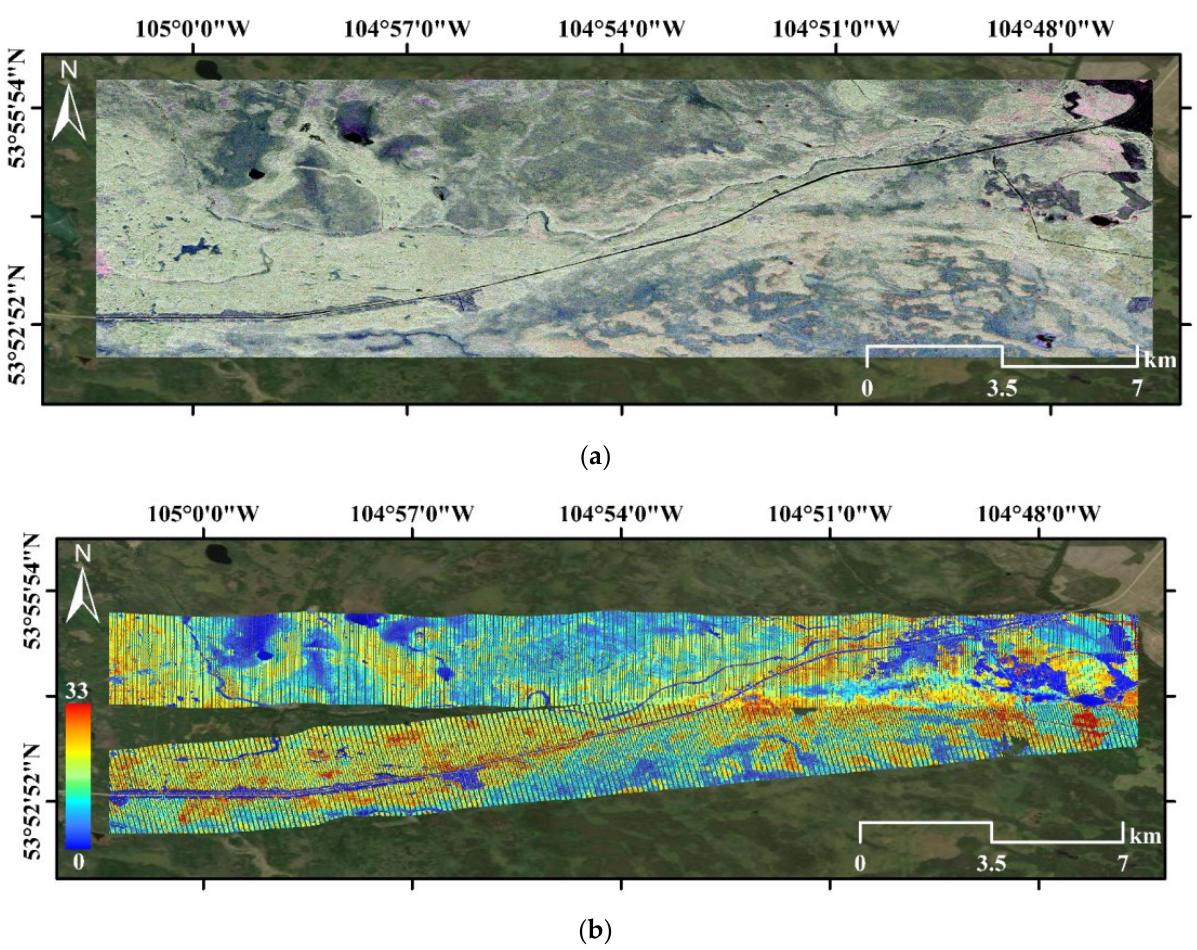
Figure 1. Study area in the Boreal Ecosystem Research and Monitoring Sites (BERMS): ( a ) UAVSAR Pauli color composite image. Red: | S HH − S VV | 2 , Green: 2 | S HV | 2 , Blue: | S HH + S VV | 2 ; ( b ) LVIS 2019 RH100 height.